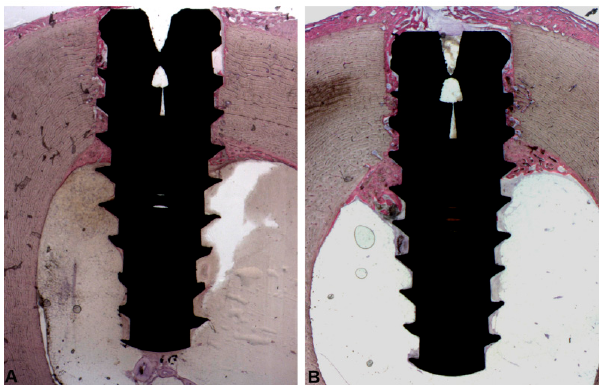
Figure 4. At low-magnification, healing of the tissues 30 day after implant placement in Group 1 ( A ) and Group 2 ( B ). The coronal portion of the implants was located in the cortical portion while the middle and apical implant portions were immersed in the marrow cavities of the tibiae. (Acid fuchsin-Toluidine blue 6X) .